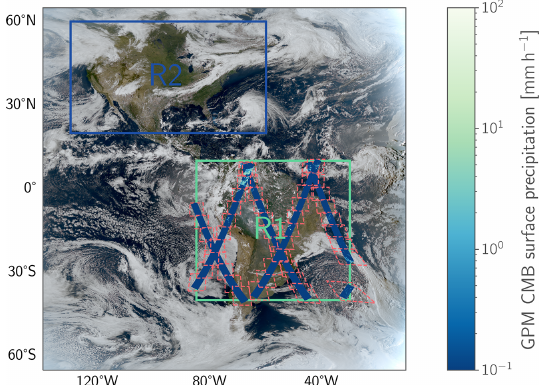
Figure 2. GOES-16 true-color composite from 23 September 2019 (generated using the natural_color composite in Satpy; Ras- paud et al., 2021). The rectangle R1 marks the domain over South America, which was used for the extraction of training and testing collocations between GOES-16 ABI and GPM CMB. Dashed poly- gons show the boundaries of the training scenes extracted for this day together with the collocated GPM CMB results. The rectangle R2 marks the secondary domain, which is used as an additional test domain to assess the impact of the spatially limited training domain.